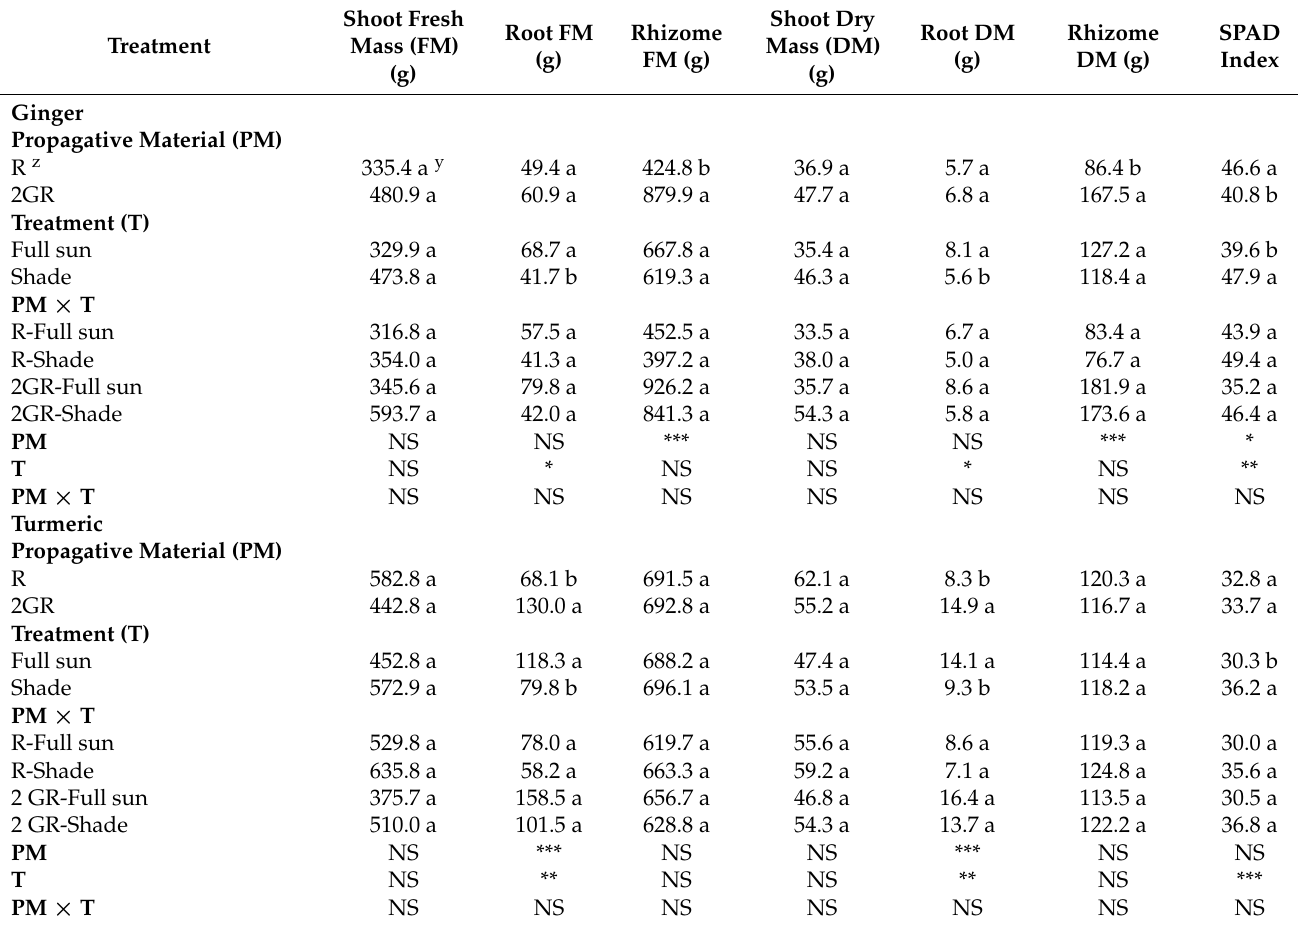
Table 3. Mean values and mean grouping comparison for different propagative materials of ginger and turmeric plants grown in the field under full sun and shade in Experiment 1.